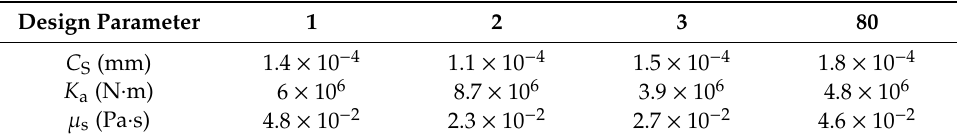
Table 2. The design matrix of the SFD parameters.